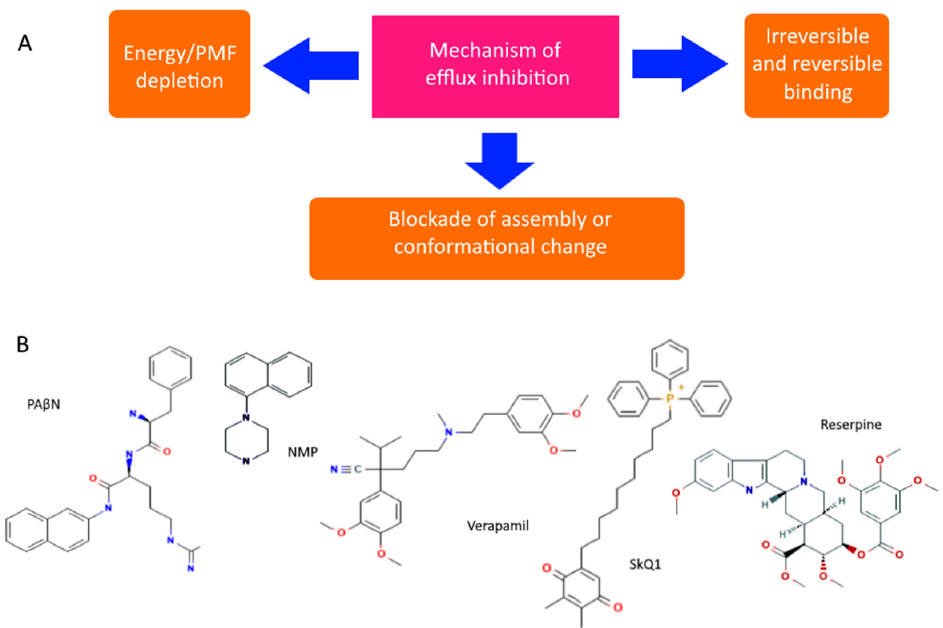
Figure 4. Diagram showing the main mechanisms of overcoming non ‐ specific protection due to in ‐ hibition of MDR pumps ( A ) and some MDR pump inhibitors ( B